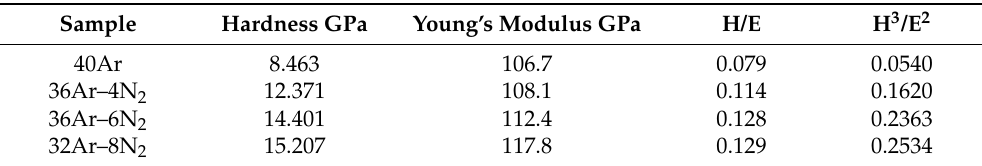
Table 2. Surface hardness and elastic modulus of Ta 2 O 5 coatings were prepared under different sputtering gas conditions.